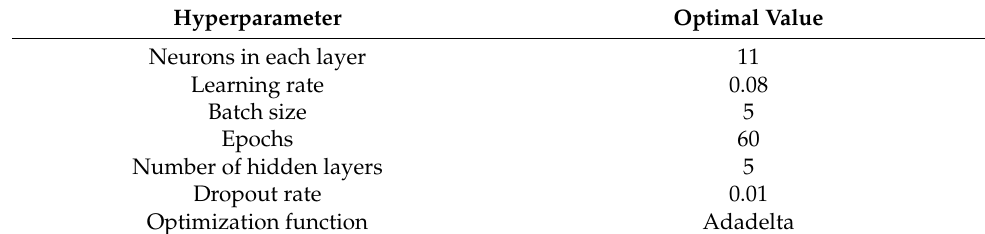
Table 5. List of the optimal hyperparameters computed by the Bayesian approach.